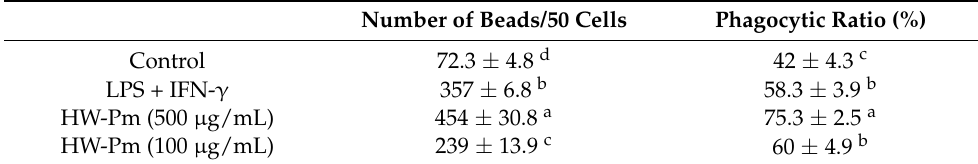
Table 2. Effect of HW-Pm on phagocytosis of fluorescents beads by RAW 264.7 macrophages.